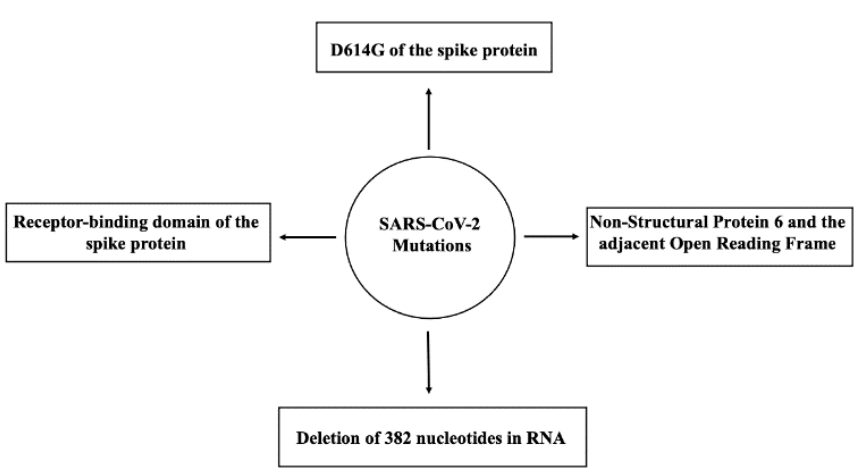
Figure 3. Range of SARS-CoV-2